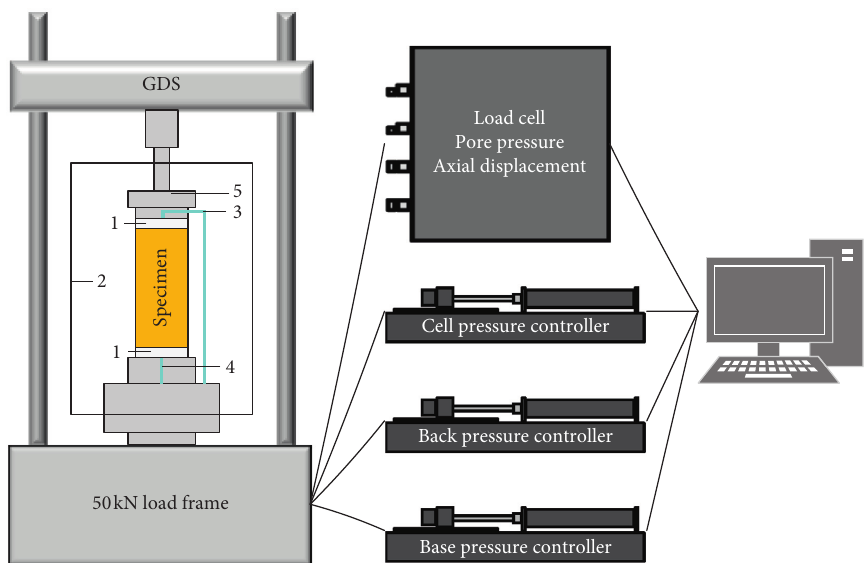
Figure 7: GDS structural diagram. (1) Permeable stone with filter paper; (2) cell pressure chamber; (3) back pressure; (4) base pressure; (5) axial